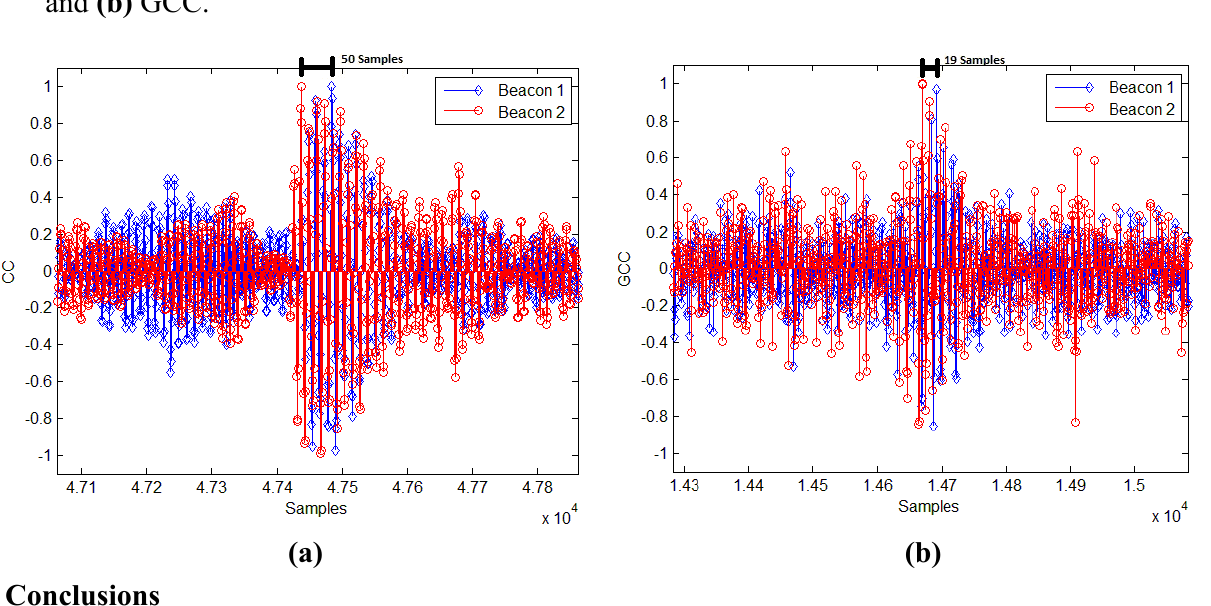
Figure 16. Beacon detection in the position 2 with real signals ( m = 1) applying: (a) CC and (b)